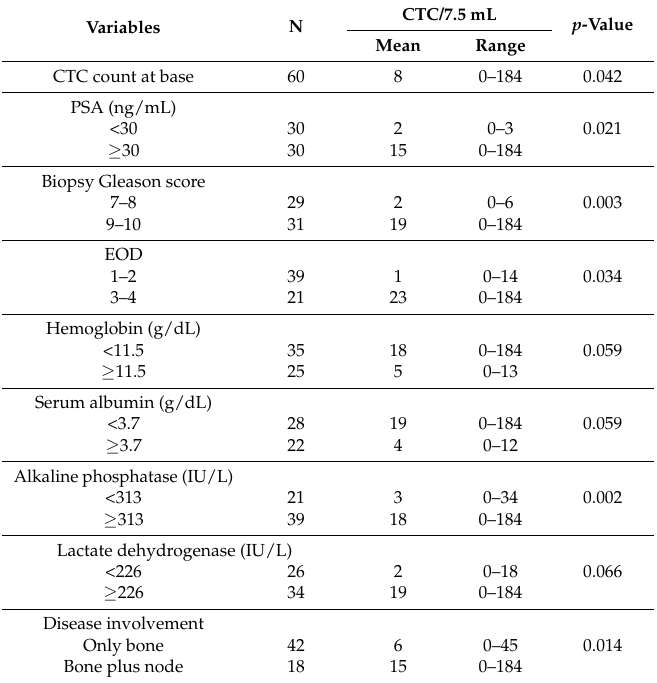
Table 1. Association between circulating tumor cells (CTC) and baseline